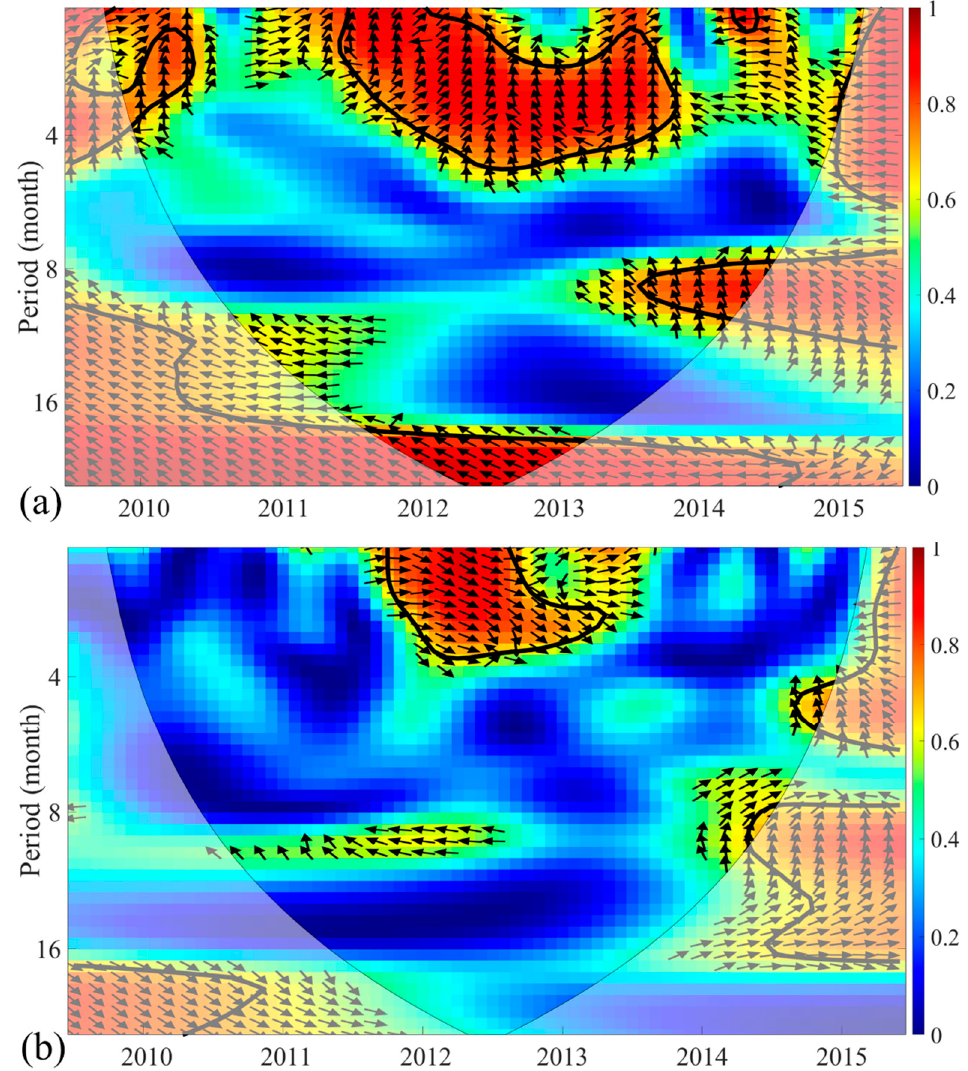
Figure 17. The wavelet coherence (WTC) between the PDSI and TVDI time series in the middle and lower reaches of the Yangtze River from 2010 to 2015. The abscissa and ordinate represent the year and period (month), respectively, and the color bar on the right is the wavelet energy. The arrows indicate the relative phase relationship. ( a ) The WTC of the PDSI and TVDI in rain-fed arable land. ( b ) The WTC of the PDSI and TVDI in irrigated arable land.